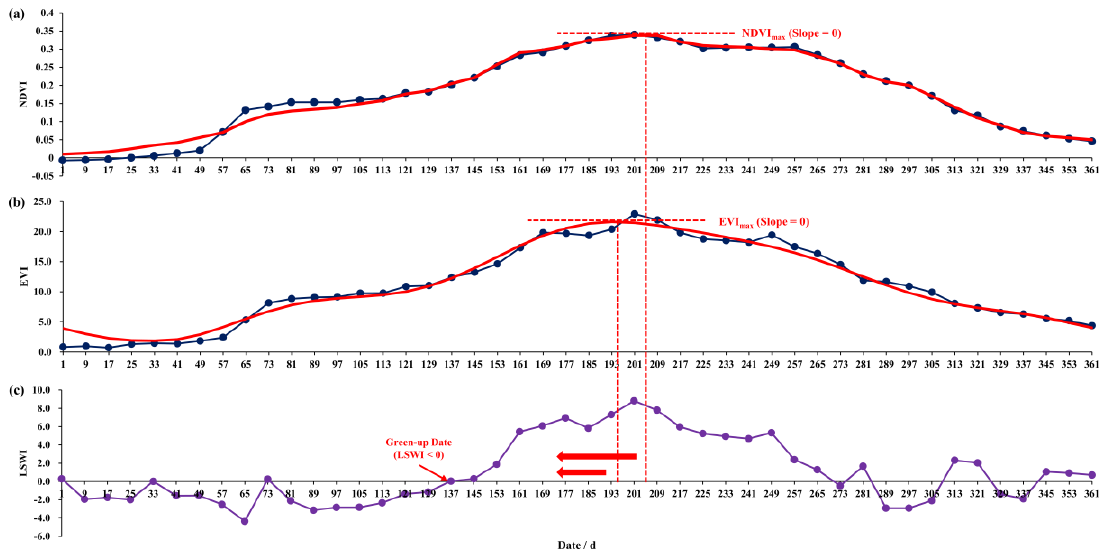
Figure 2. ( a ) Temporal variations of ( a ) NDVI (both original and after HANTS), ( b ) EVI (both original and after HANTS) and ( c )